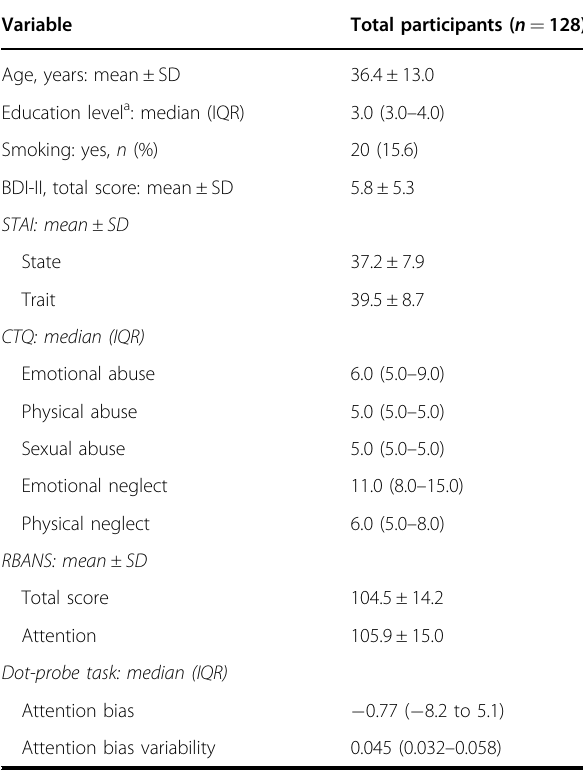
Table 1 Demographic and psychological